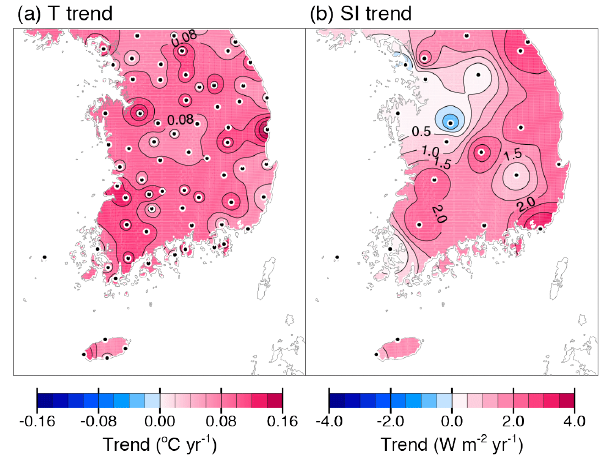
Figure 4. Spatial distributions of temporal linear trends of (a) daily average T and (b) daily average SI for the period 1999–2010 using data from 72 and 22 weather stations (black dots) of KMA, respec-